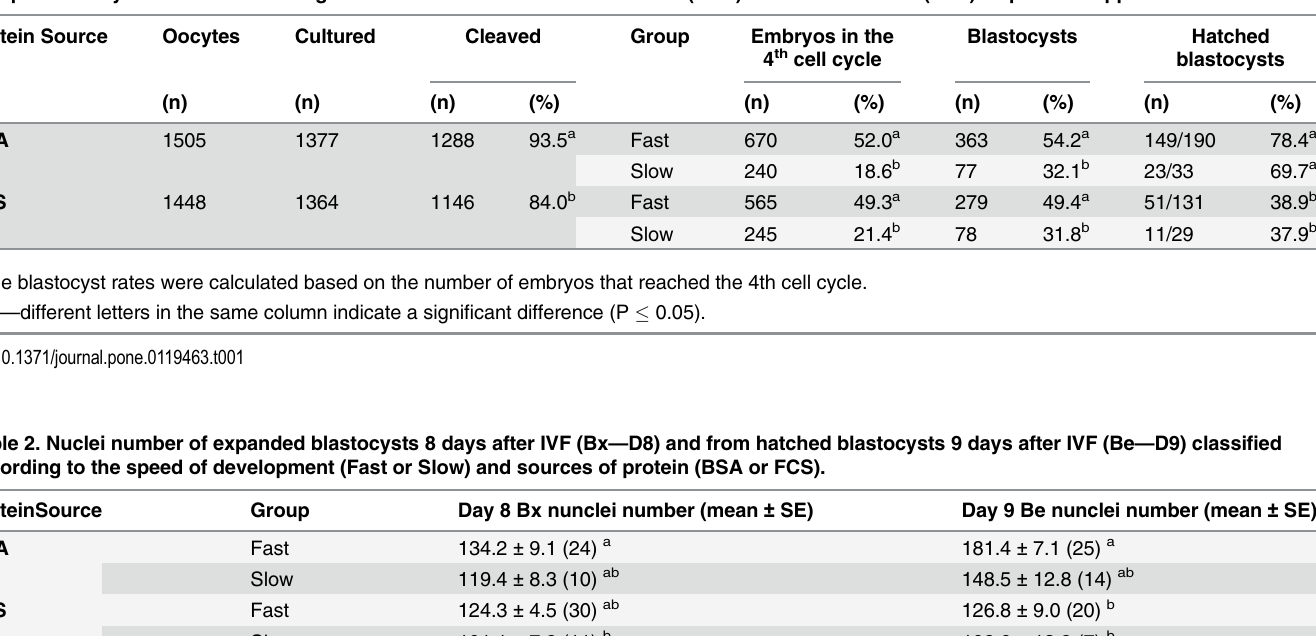
Table 1. Cleavage, blastocyst (8 days post-insemination) and hatching rates (9 days post-insemination) of the Fast and Slow development groups of embryos at the 5 – 8 cell stage cultured with bovine serum albumin (BSA) or fetal calf serum (FCS) as protein supplements Protein Source